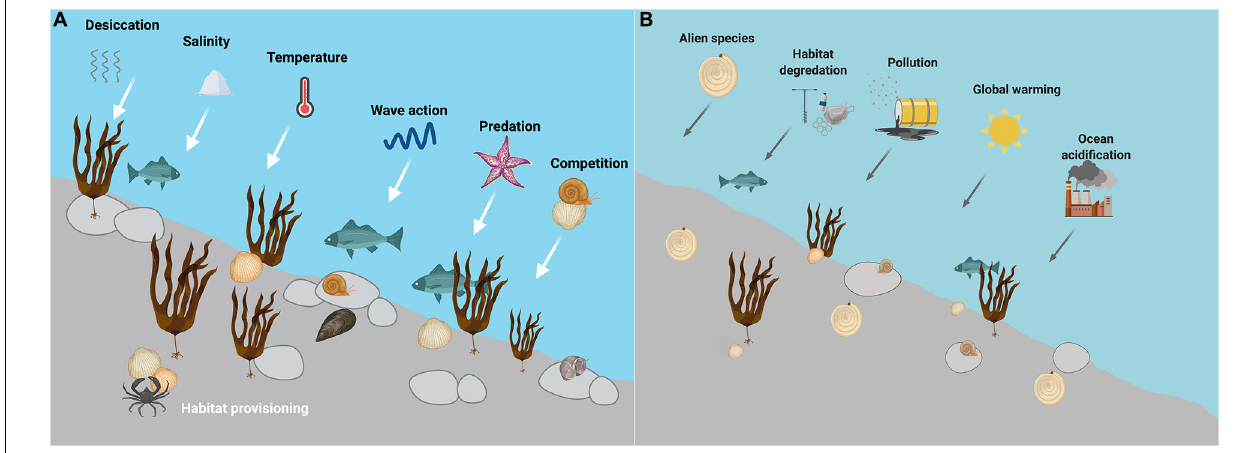
FIGURE 1 | (A) Natural and (B) anthropogenic drivers acting on rocky intertidal systems. In an undisturbed environment, mainly abiotic factors (such as wave action, temperature, salinity, and desiccation) limit the upper species zonation, whereas biotic interactions (e.g., predation and competition) shape the lower species zonation. Local anthropogenic drivers such as alien species introductions, habitat degradation, and pollution, as well as global anthropogenic drivers such as global warming and ocean acidification act on top of natural drivers and increase the level of stress on intertidal species. Pollution comprises drivers such as eutrophication, oil spills, toxins, endocrine disruptors, and toxic algal blooms. The drivers indicated in this figure are not exclusive, but synthesize the main drivers identified in this review. The arrows are not indicative of drivers affecting different intertidal